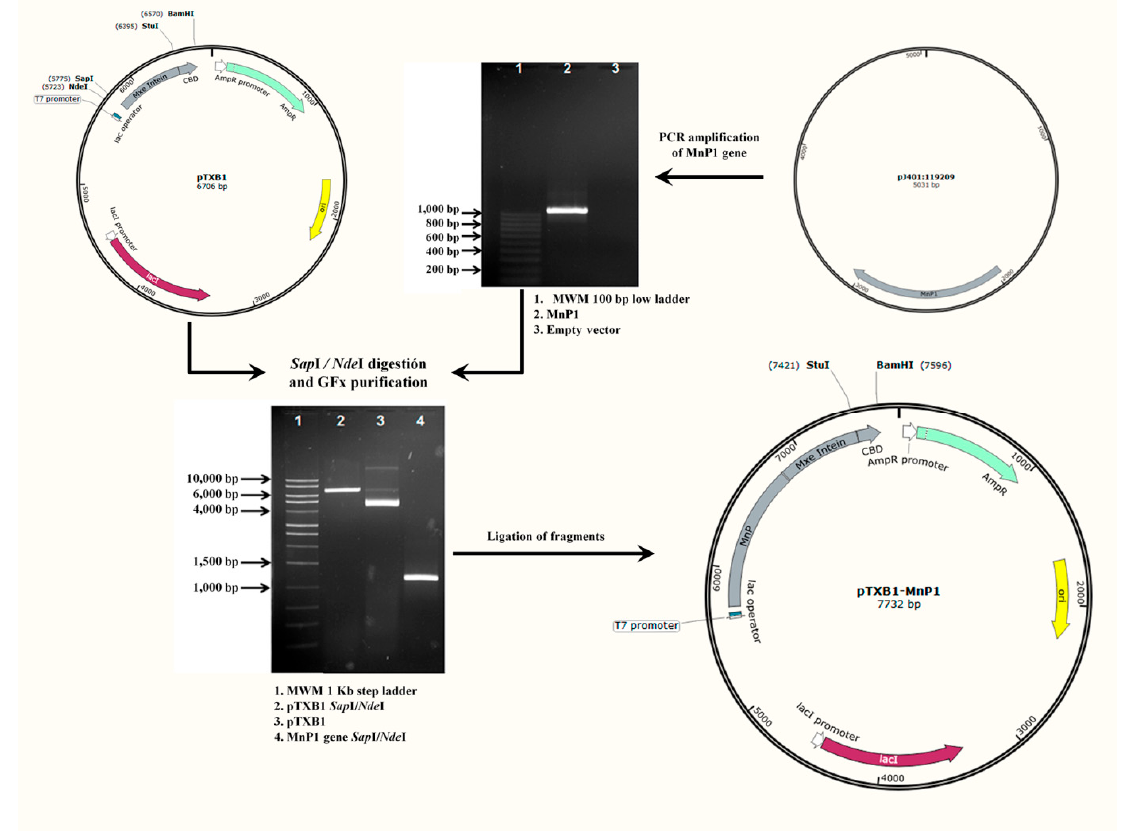
Figure 1. Schematic representation for the construction of the recombinant plasmid pTXB1-MnP1.